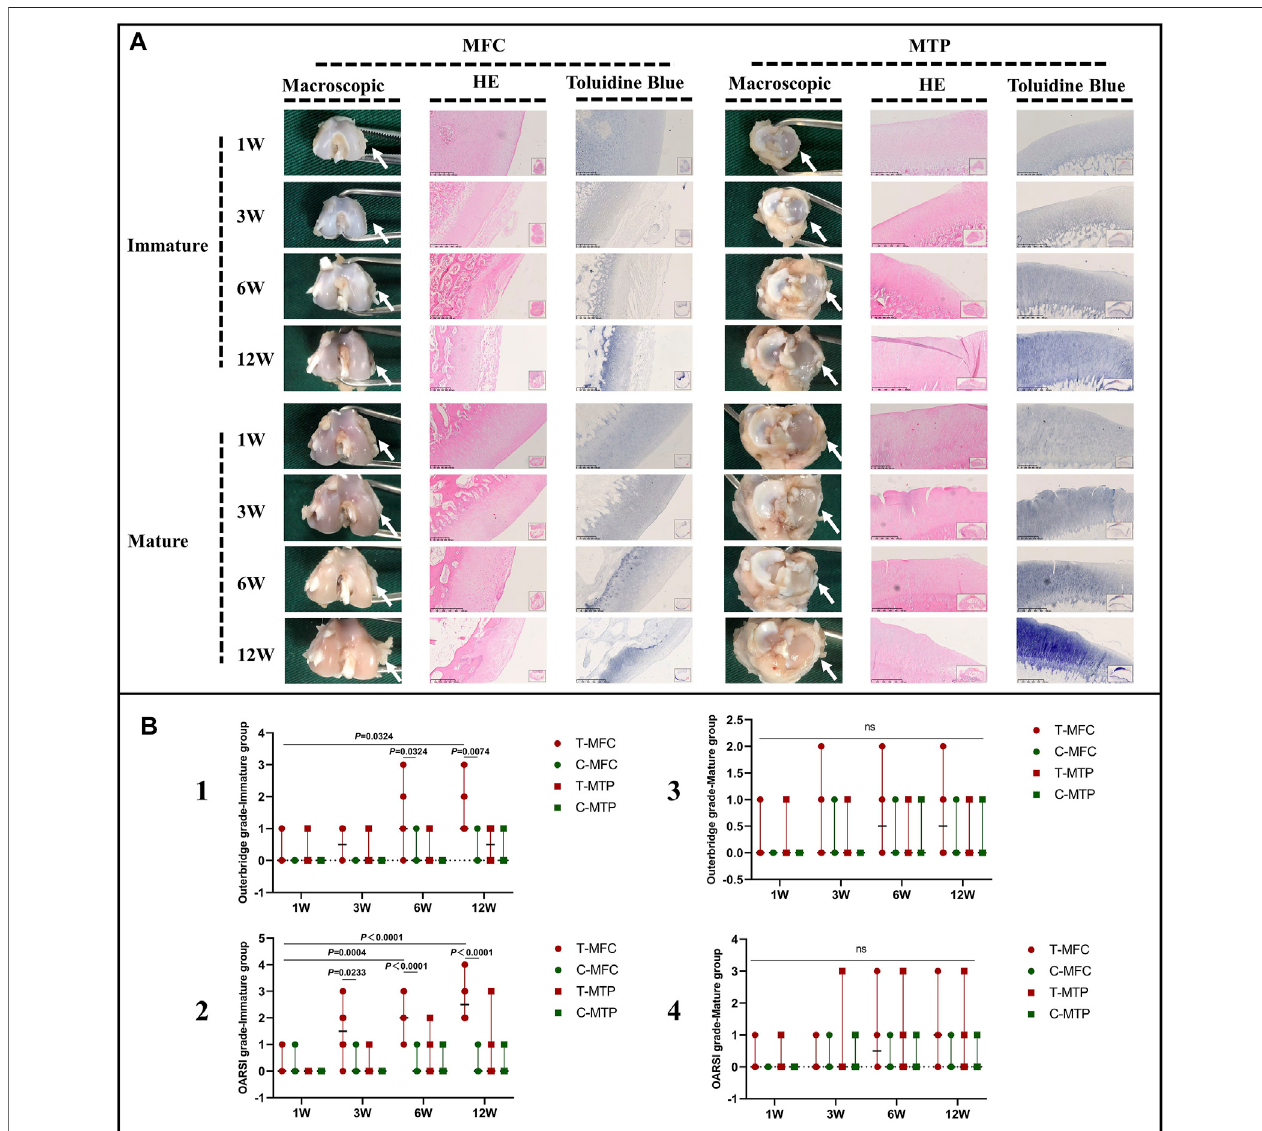
FIGURE 10 | Macroscopic and histological evaluation of cartilage degeneration. (A) Macroscopic and histological evaluation of MFC and MTP cartilage degenerationintheimmatureandmaturegroups. (B) Outerbridgescoringand histological OARSIscoringforcartilagedegeneration.Thewhitearrowsindicate theMFC or MTP. Scores are expressed as median values with 95% CIs. n (cid:1) 6. ns: no signi fi cant differences.